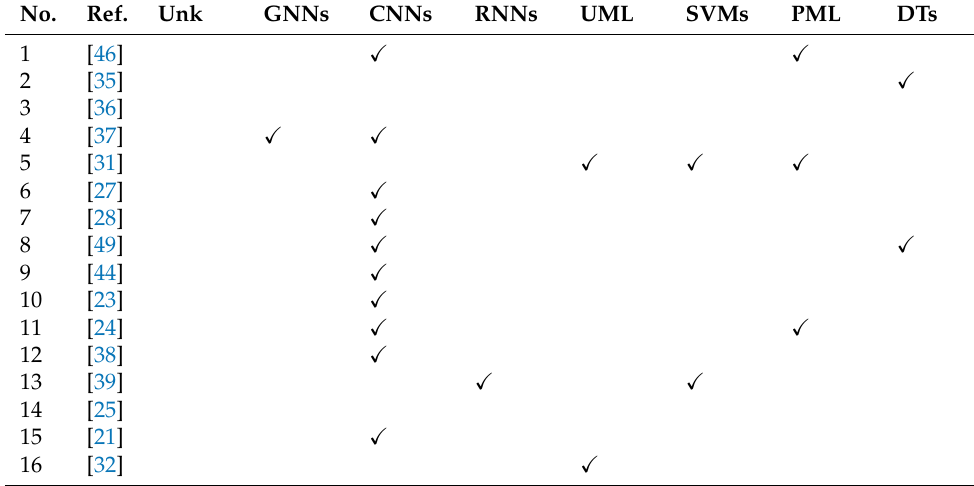
Table 8. The machine learning techniques utilized in each work. Unk. means that the papers do not specify what method they used. GNNs are graph neural networks. CNNs are convolutional neural networks. RNNs are recurrent neural networks. UML stands for unsupervised machine learning. SVMs are support vector machines. PML stands for probabilistic machine learning. Finally, DTs are decision